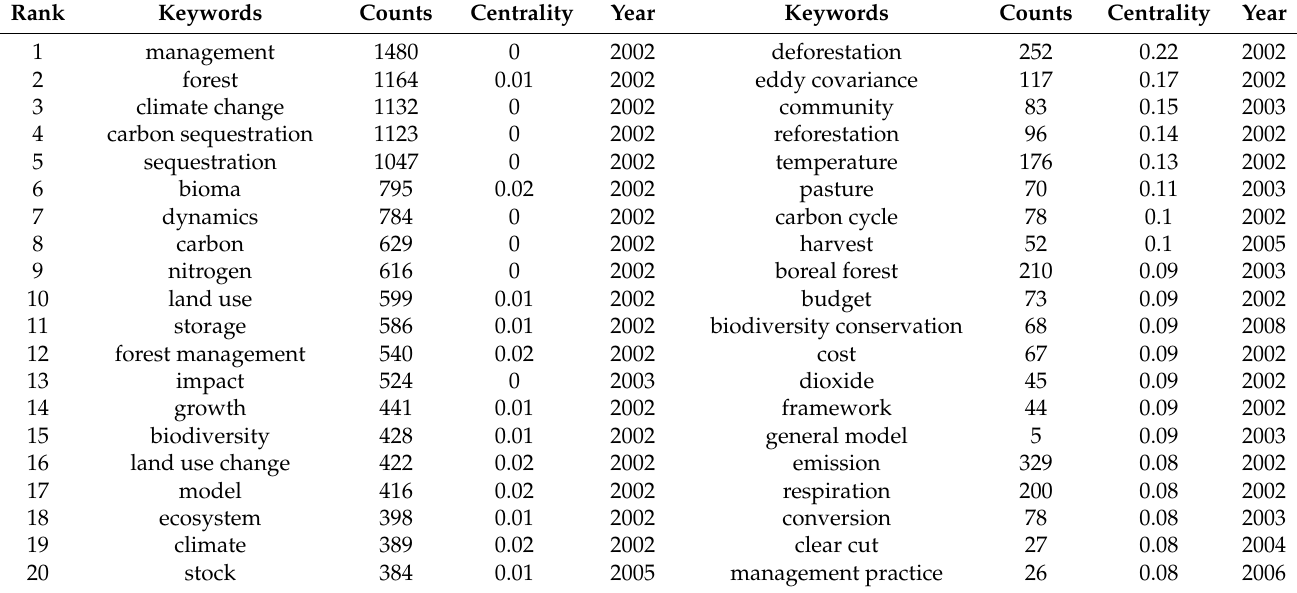
Table 7. Top 20 keywords in frequency and centrality between 2002 and